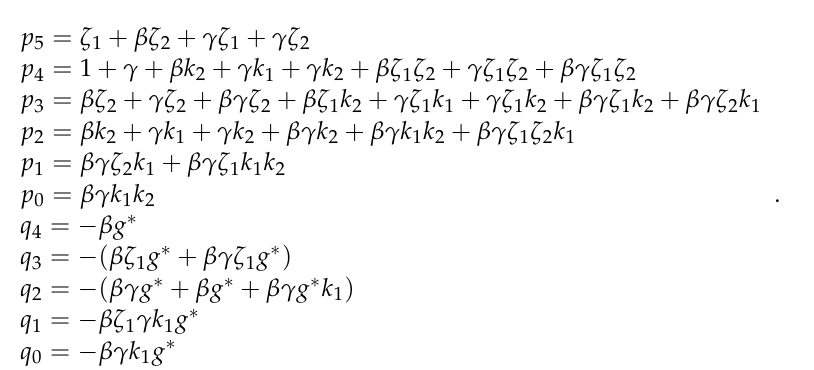
Figure 3. Time-delay independent stability: Time-delay independent stability region; Time-delay dependent stability region; Unstable region.